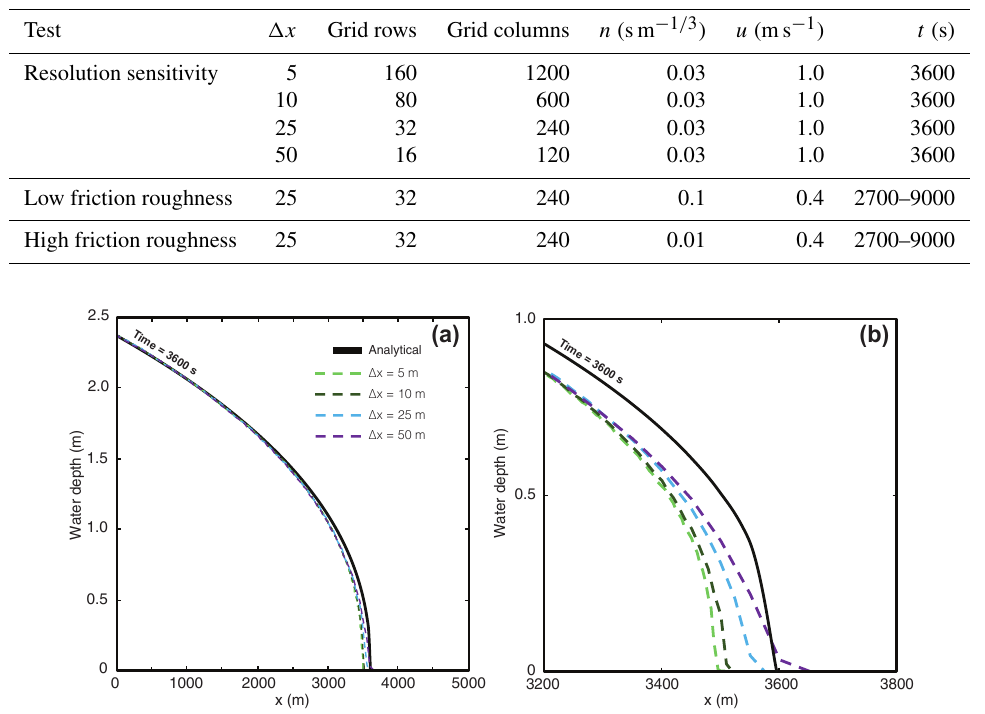
Figure 6. Sensitivity of the Landlab OverlandFlow component to changes in grid resolution, tested against the analytical solution. Panel (a) is illustrated in the same manner as Bates et al. (2010, Fig. 2) and shows water depths plotted against distance, modeled at four different grid resolutions, at t 3600s. Panel (b) is a zoomed-in image of all wave fronts from panel (a) =